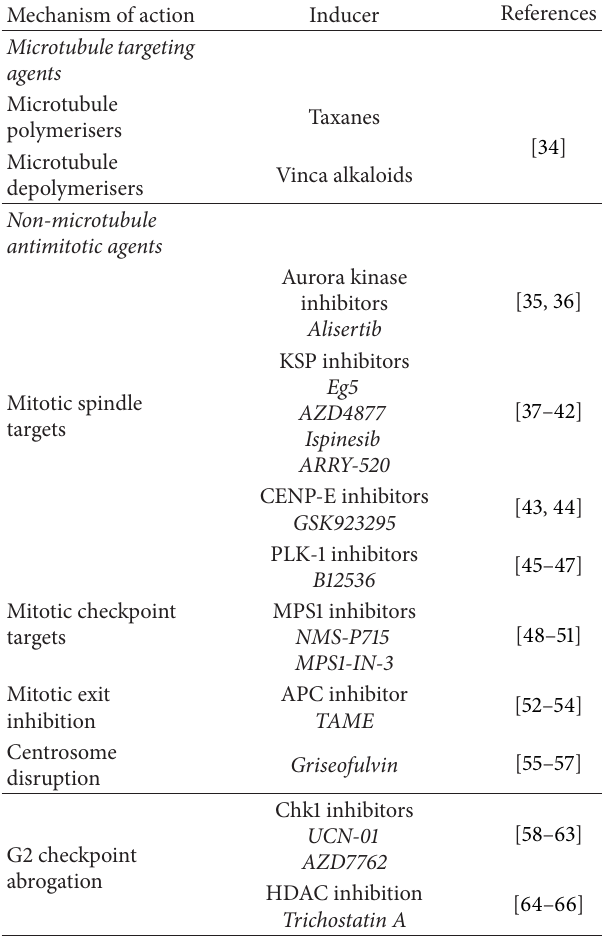
Table 1: Exploiting mitotic catastrophe in cancer